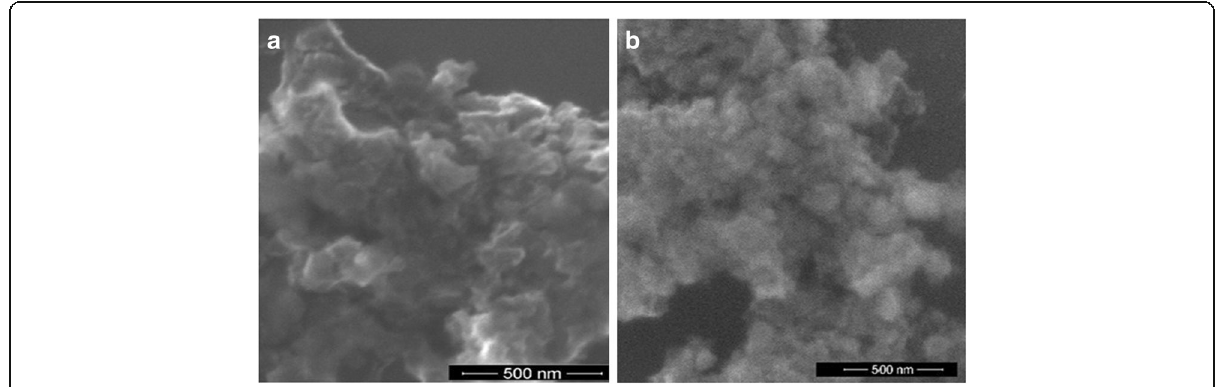
Fig. 4 SEM images of Fe x Ti y O z ( a ) and N/Fe x Ti y O z ( b ) films treated at 450 °C